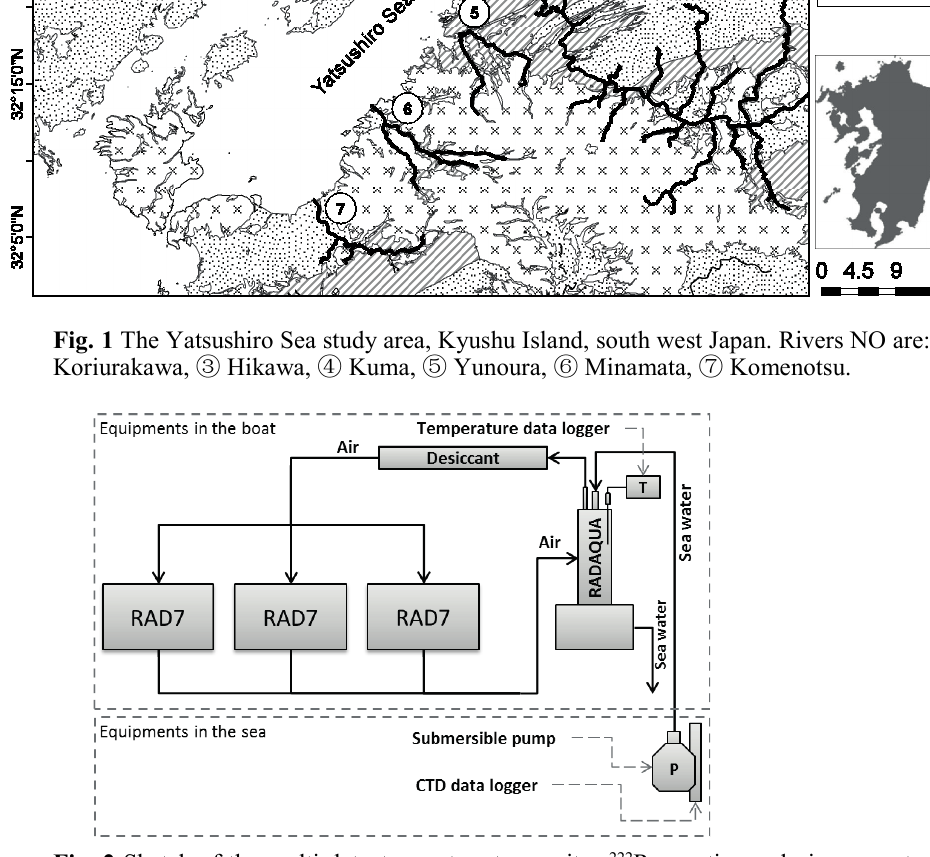
Fig. 2 Sketch of the multi-detector system to monitor 222 Rn continuously in sea water. Modified from Dulaiova et al.